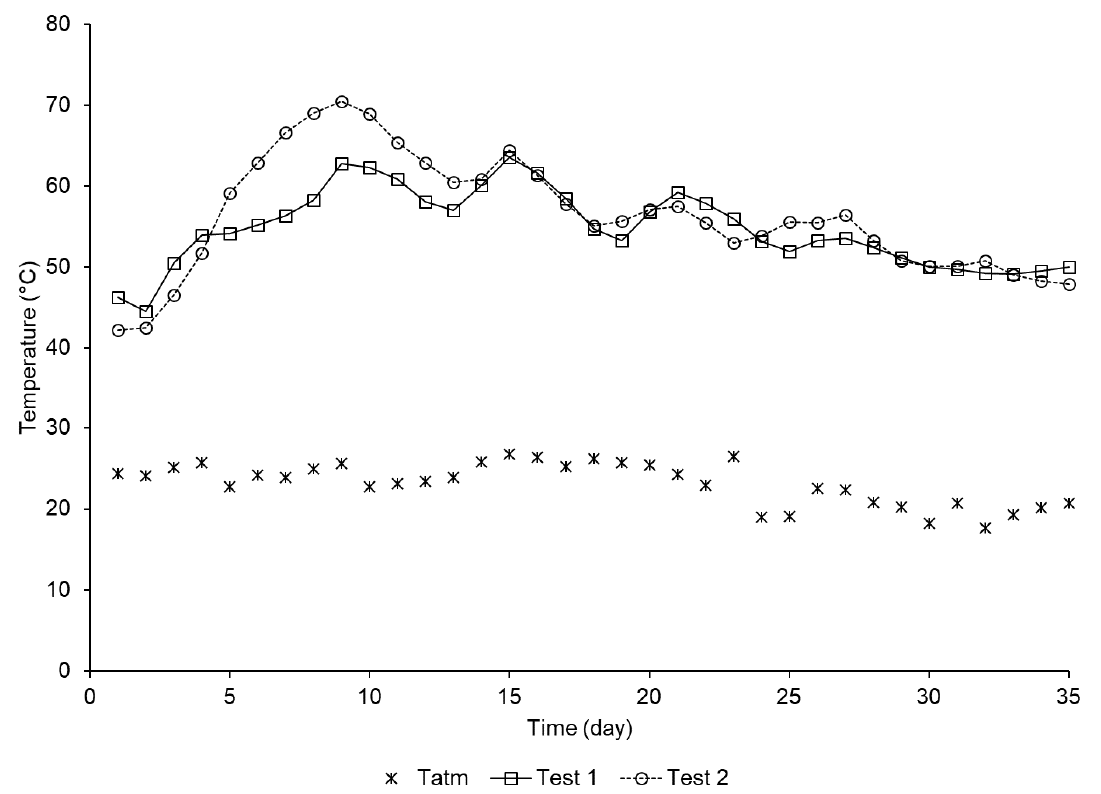
Figure 5. Daily average environmental temperature and daily average biomass temperatures (at 55 cm of depth).